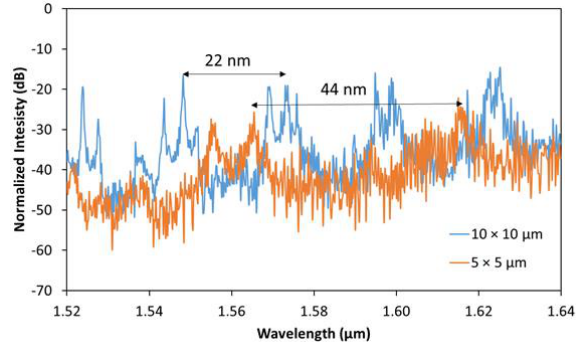
Figure 7. Experimental Drop R spectrum for different cavity sizes with optimized coupler lengths.